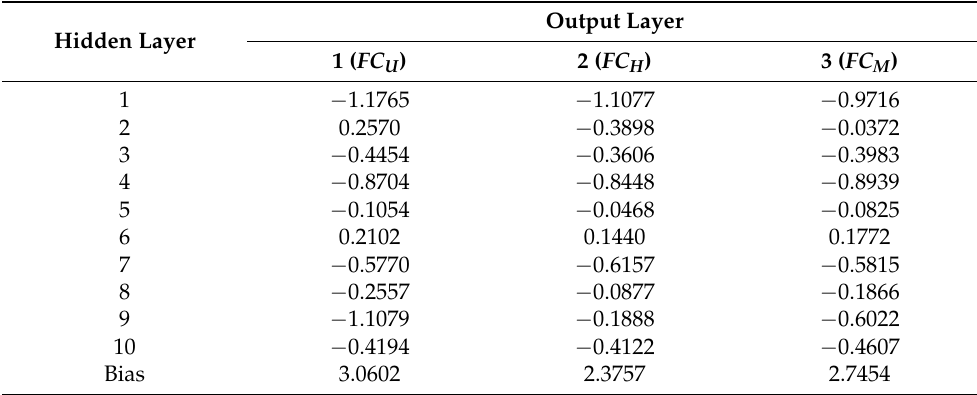
Table A2. Weights between the hidden layer and the output layer in the MLP 22-10-3 artificial neural network.